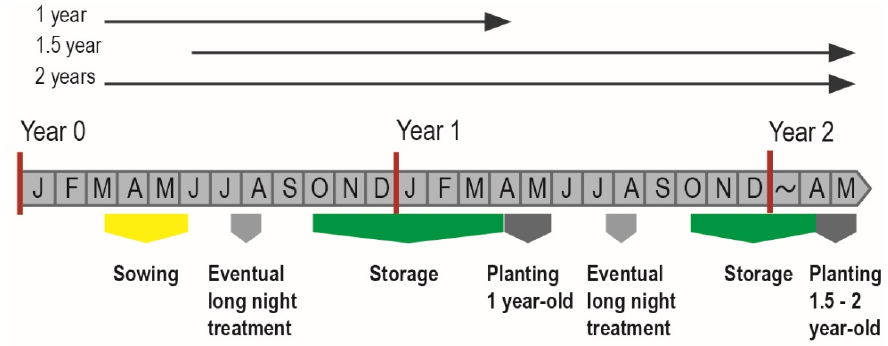
Figure 2. Cultivation scheme of containerized conifer seedlings in Swedish forest nurseries (adapted from [26]).